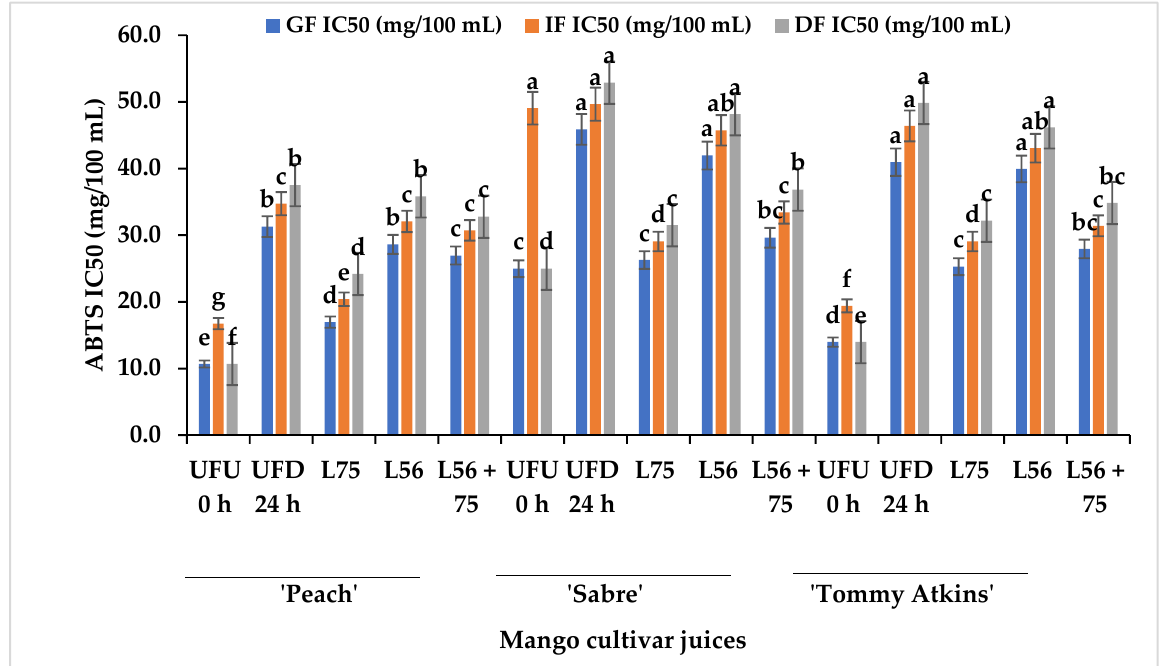
Figure 4. ABTS antioxidant scavenging activity of LAB-fermented MJs from different cultivars after in vitro GI digestion. Bars are mean ± standard deviation and different alphabets on similar colored bars indicate significant difference at p ≤ 0.05. Keys: Ltp. plantarum (L75); Leu. pseudomesenteroides (L56); Leu. pseudomesenteroides 56 + Ltp. plantarum 75 (L56 + 75), gastric fraction (GF), Intestinal phase, Dialysis phase (DF); 2.2-Azinobis-(3-ethyl-benzothiazoline-6- sulfonic acid (ABTS); UFU 0 h—raw unfermented undigested Mango juice (control); UFD 24 h—unfermented digested MJs stored for 24 h.